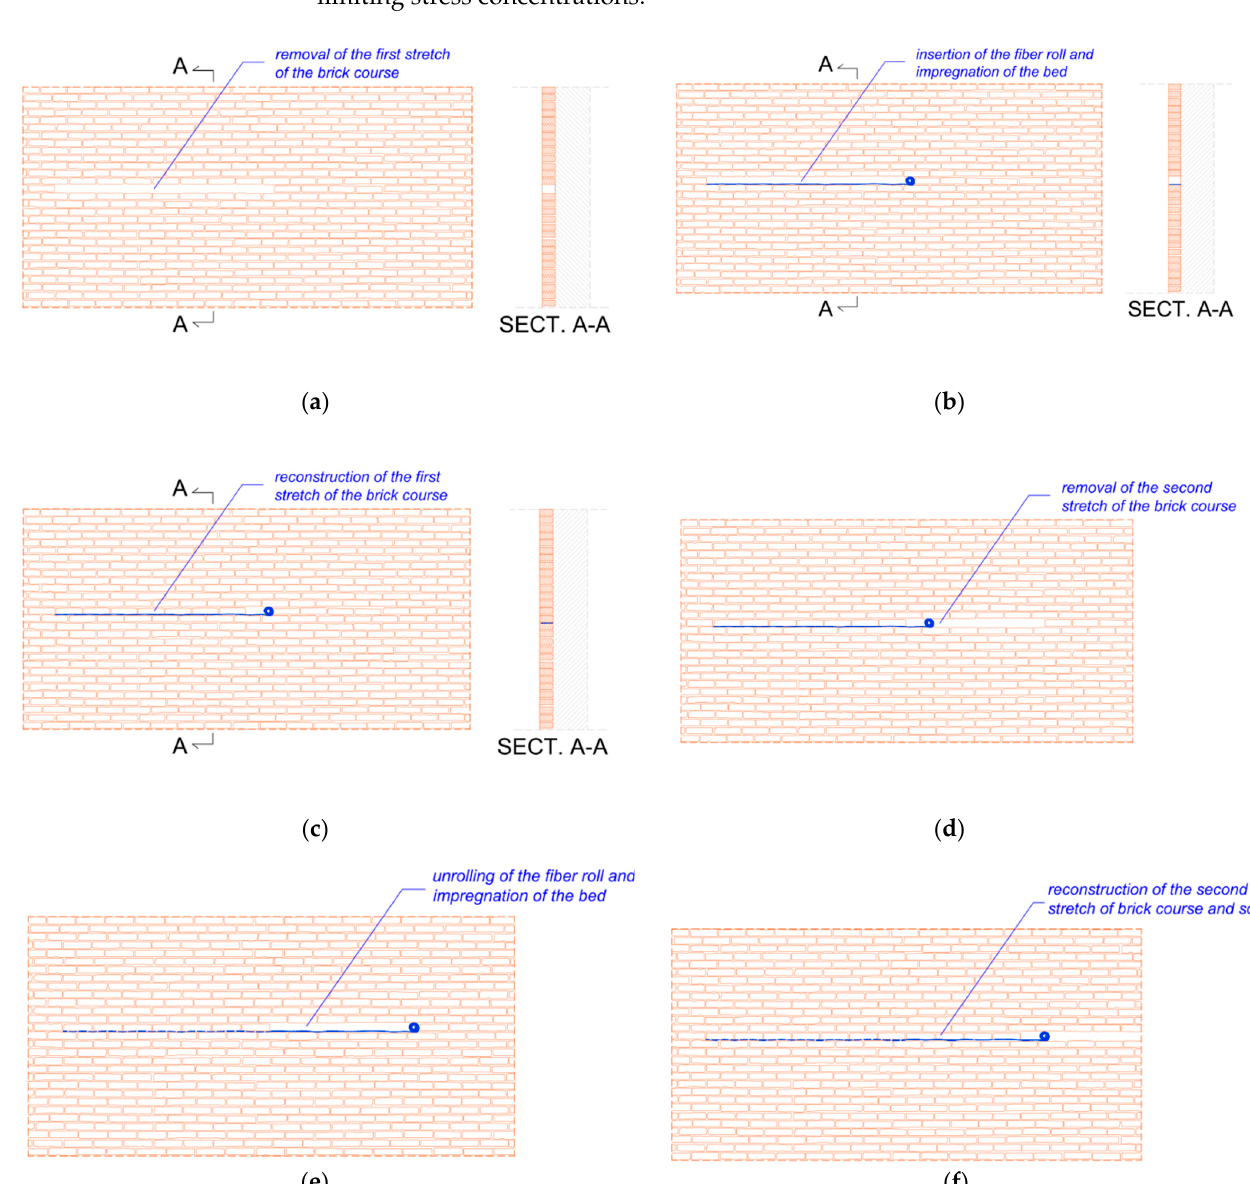
Figure 9. Phases of the proposed intervention: ( a ) removal of the first stretch of brick course; ( b ) unrolling and impregnation of the fiber roll; ( c ) reconstruction of the first stretch of the brick course; ( d ) removal of the second stretch of brick course; ( e ) unrolling and impregnation of the fiber roll; ( f ) reconstruction of the second stretch of the brick course.